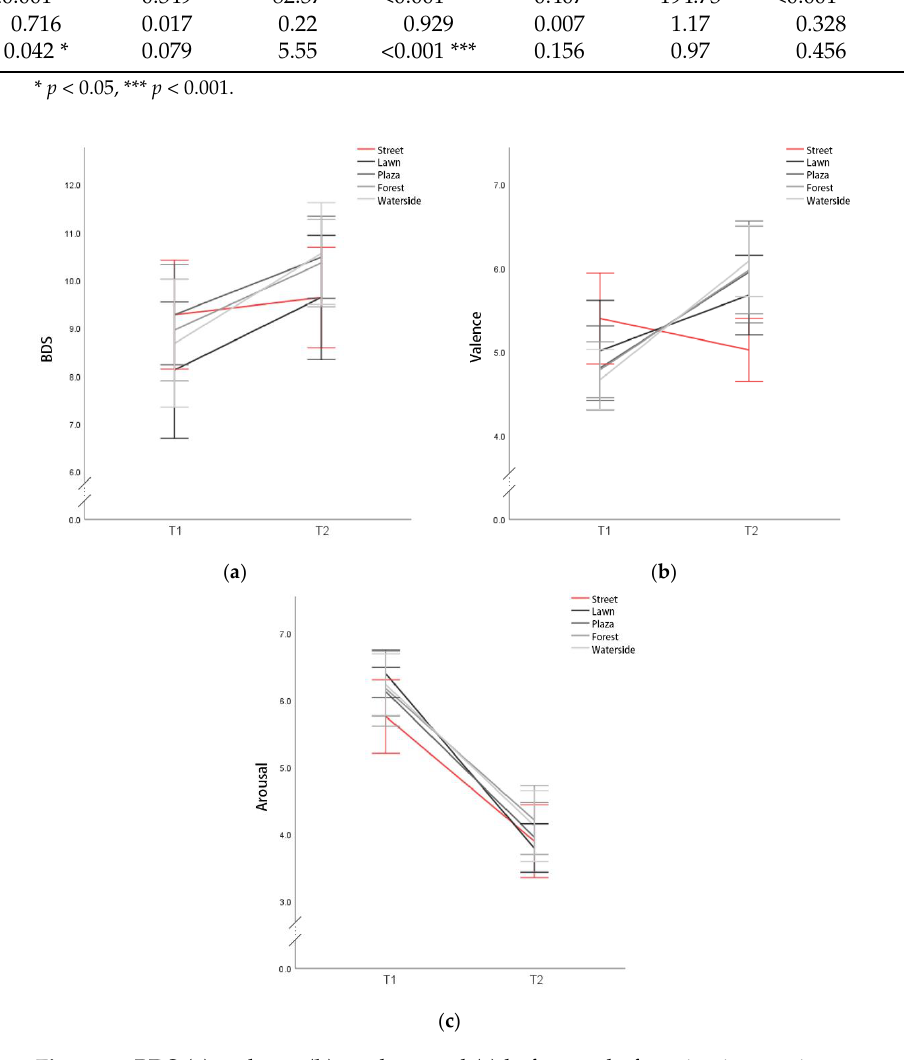
( a ) ( b ) Figure 4. Changes in mean BDS score ( a ) and valence ( b ) in different environments during the ex- periment. Pairwise comparisons between pre-video (T1) and post-video (T2) in each environmental treatment are marked. * p < 0 .05, ** p < 0 .01, *** p < 0 .001. 3.3. Emotion 3.3.1. Valence We ran a mixed-model 5 × 3 RM-ANOVA for valence and arousal, in which treatment (green streets, lawns, forests, watersides, and plazas) was the between-subjects variable and time (T0: baseline, T1: pre-video, and T2: post-video) was the within-subjects variable. Table 1 shows the results of the RM-ANOVA. For valence, the results of the RM-ANOVA revealed no significant treatment effect. The subjects ’ valence changed significantly over time ( F(2,240) = 82.37, 𝑝 < 0.001,η p2 = 0.407 ). In addition, a significant interaction effect on valence ( F(8,240) = 5.56, 𝑝 < 0.001,η p2 = 0.156 ) was detected between time and treat- ment (Figure 3b). To compare participants ’ valence at different time points, we examined